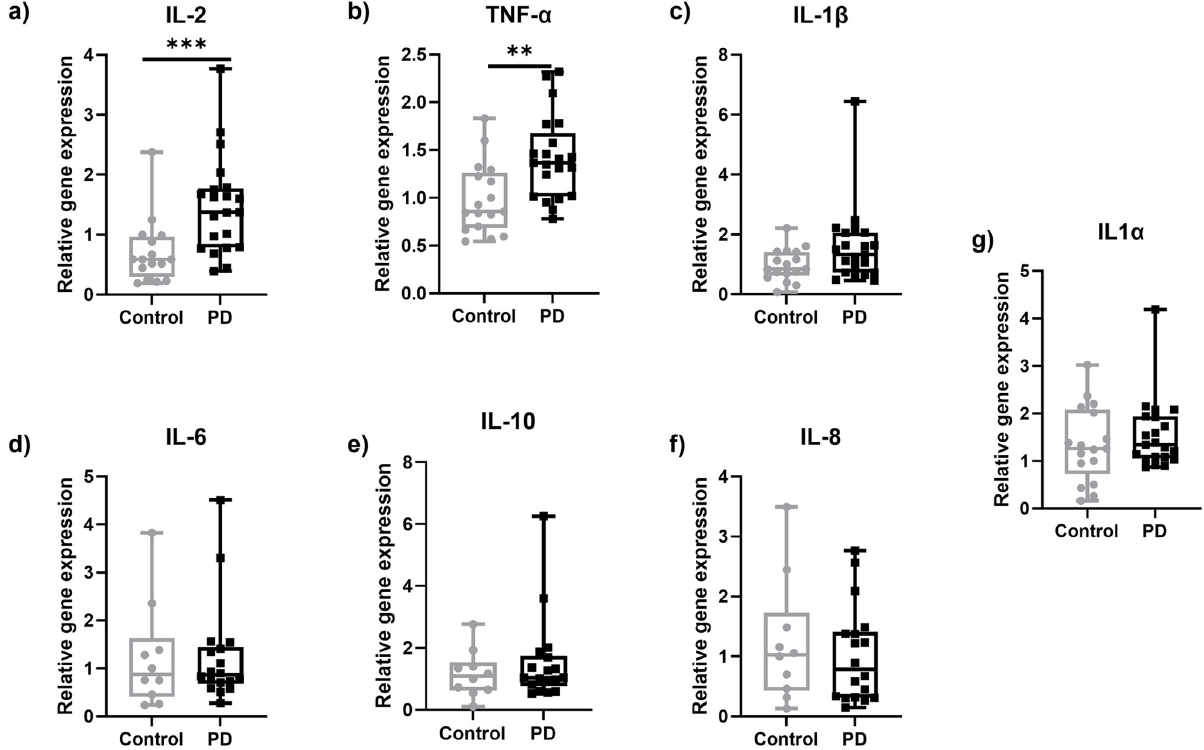
Fig 2. Gene expression of selected proinflammatory cytokines in skin punch biopsy samples obtained from the lateral lower leg of PD patients and healthy controls. Higher gene expression of IL-2 (a) and TNF- α (b) in PD skin biopsies compared to healthy controls. No intergroup differences were found for the investigated markers IL-1 β (c), IL-6 (d), IL-10 (e), IL-8 (f), and IL-1 α (g). Data are expressed as median and range. Abbreviations: IL = interleukin, PD = Parkinson’s disease, TNF- α = tumor necrosis factor-alpha. �� P < 0.01, ��� P < 0.001. Mann-Whitney-U test.